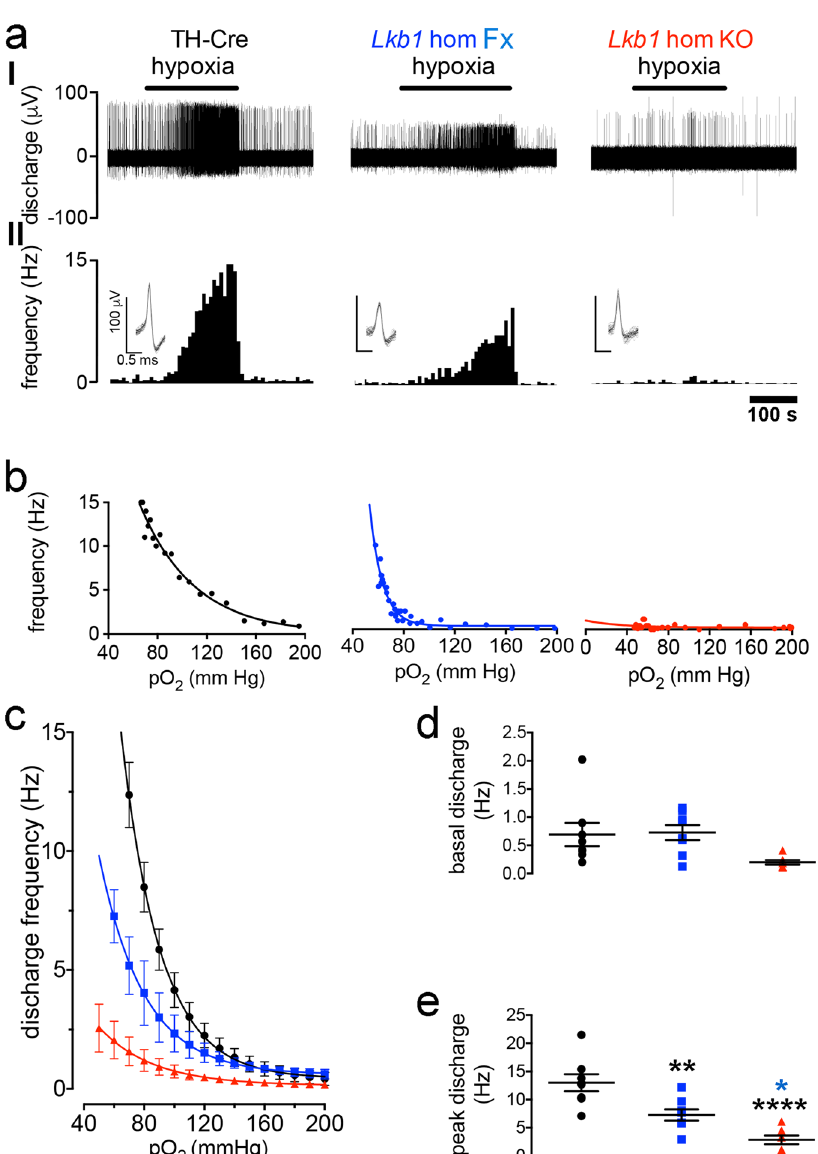
Fig. 2 Conditional deletion of Lkb1 in carotid body type I cells attenuates basal and hypoxia-evoked afferent discharge from the carotid body in vitro. a shows (I) extracellular recordings of chemoafferent discharge versus time during normoxia and hypoxia and (II) frequency-time histograms ( inset: single fi bre discriminations) for carotid bodies from control (TH-Cre, black), Lkb1 homozygous fl oxed ( Lkb1 hom Fx, blue, middle panels) and conditional Lkb1 homozygous knockout mice ( Lkb1 hom KO, red). b Exemplar frequency- P O 2 response curves for records shown in a . c Compares mean ± SEM